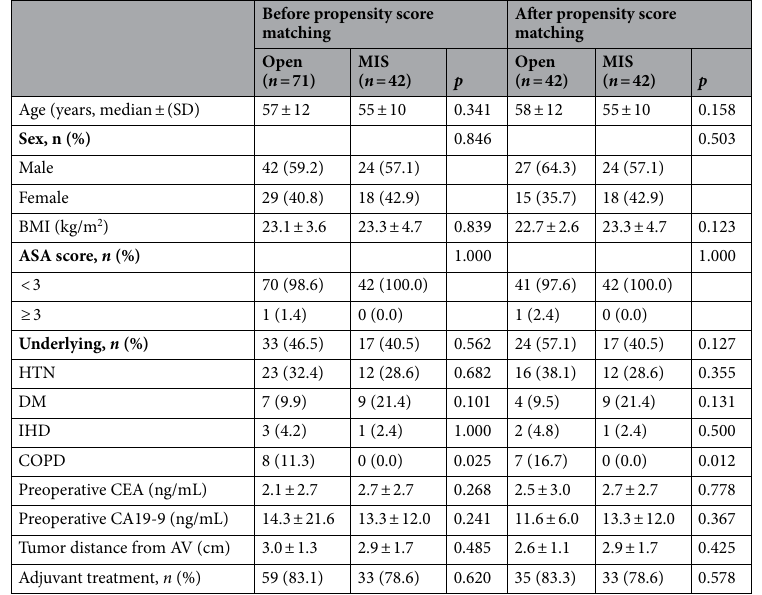
Table 2. Demographics of patients with nCRT. nCRT neoadjuvant chemoradiotherapy, MIS minimally invasive surgery, BMI body mass index, ASA American society of anesthesiologists, HTN